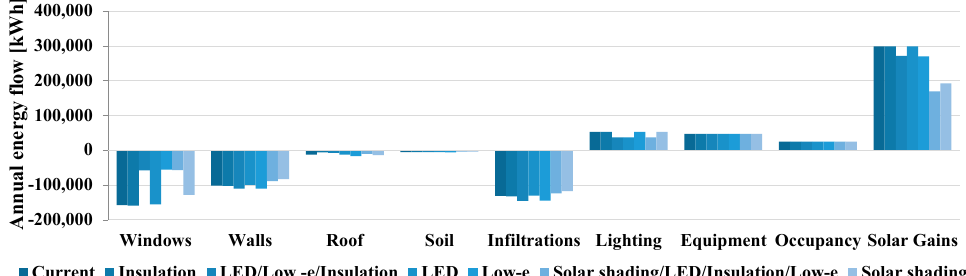
Figure 10. Impact of the retro fi t interventions on the annual energy fl ows of the building.